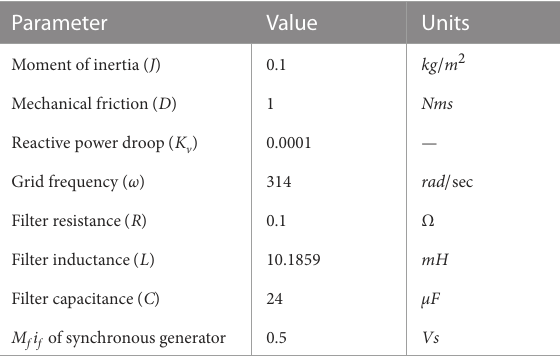
TABLE4 Parametersofcontrollerofgridformingconverter(Zhong et al.,